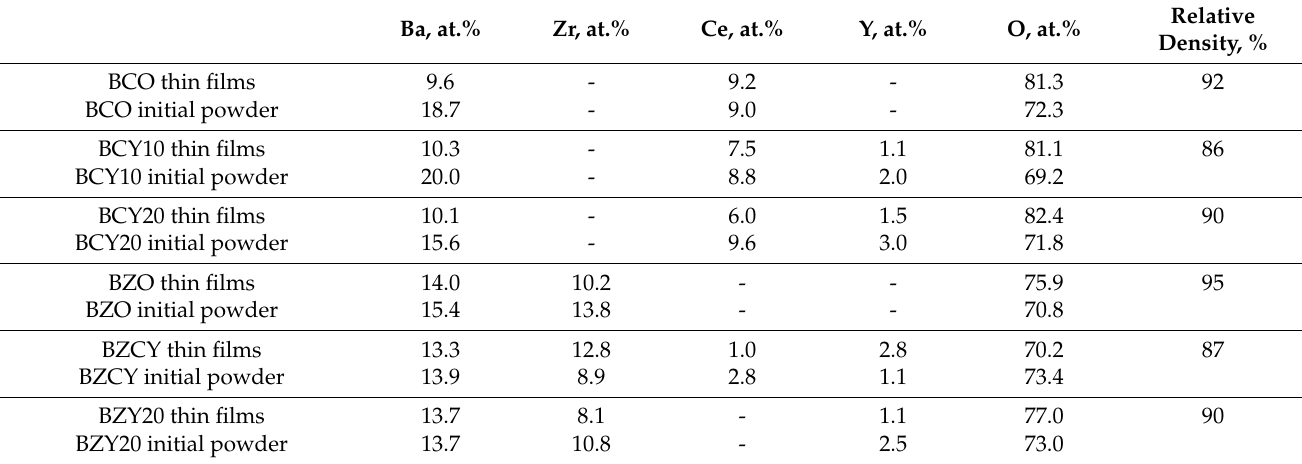
Table 1. Elemental composition of the formed thin films and initial material. Ba, at.% Zr, at.% Ce, at.% Y, at.% O, at.%